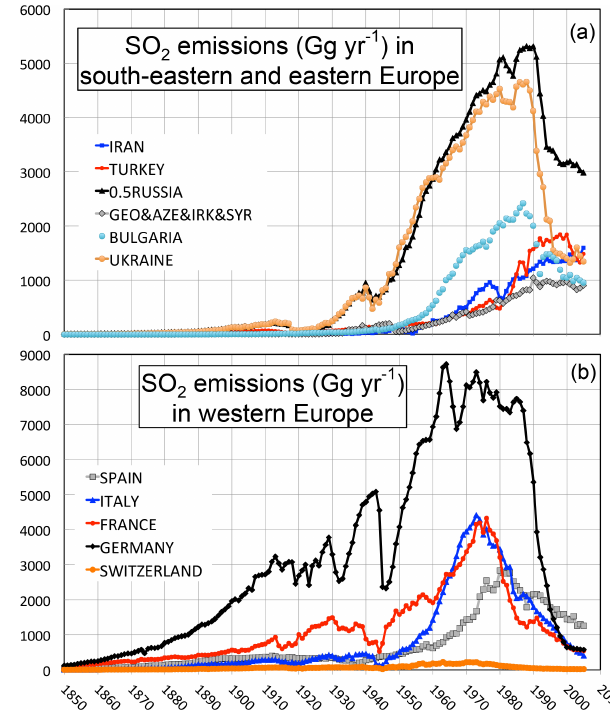
Figure 12. SO 2 emissions (from 1850 to 2005) from various countries located around the Caucasus (a) and the Alps (b) . GEO&AZE&IRK&SYR denotes emissions from Georgia, Azerbai- jan, Iraq, and Syria. Data are from Smith et al.